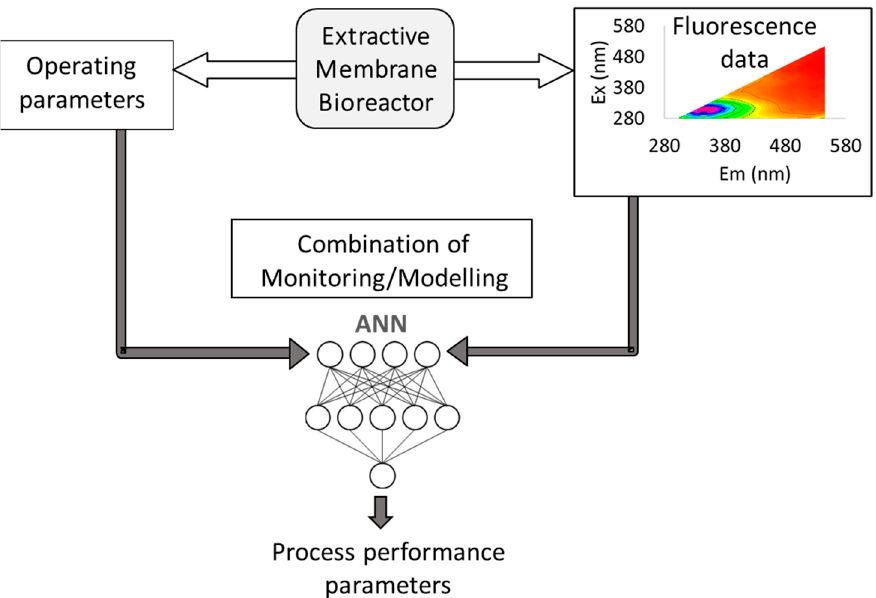
Figure 1. Schematic representation of using 2D fluorescence spectroscopy and operating parameters as inputs of artificial neural networks (ANN) to predict process performance parameters in an extractive membrane bioreactor (EMB).